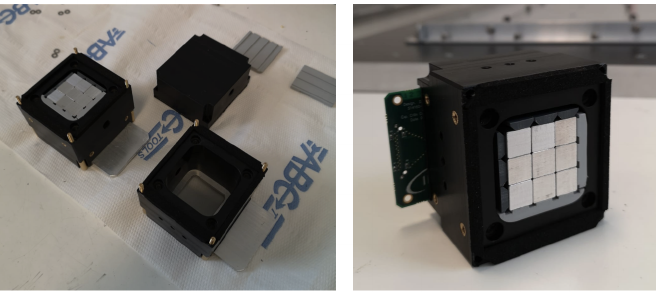
Figure 2. Mechanics of the Proto-1 asembled with fake aluminium crystals.